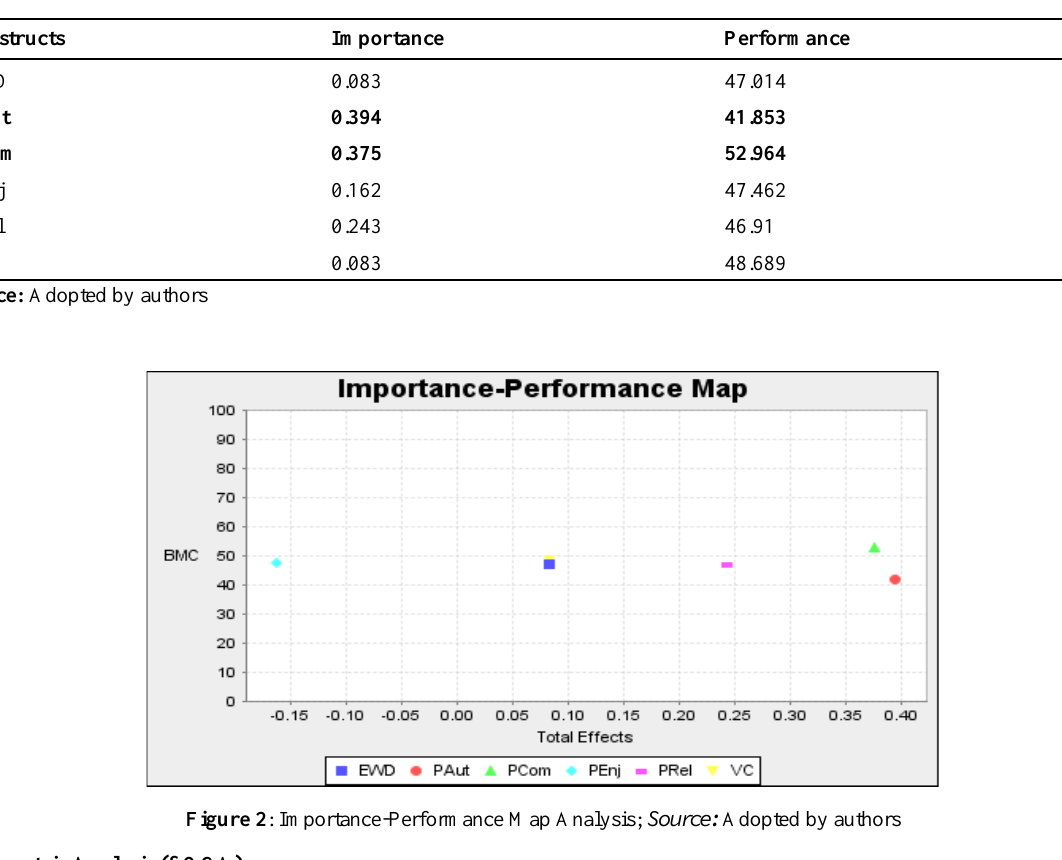
Table 5: Importance-Performance Analysis